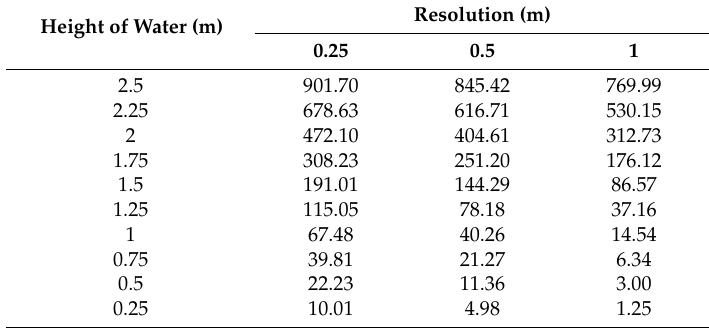
Table A3. Creek B Volume (m 3 ) from Terrestrial Lidar, rounded to two decimal places. Height of Water (m)